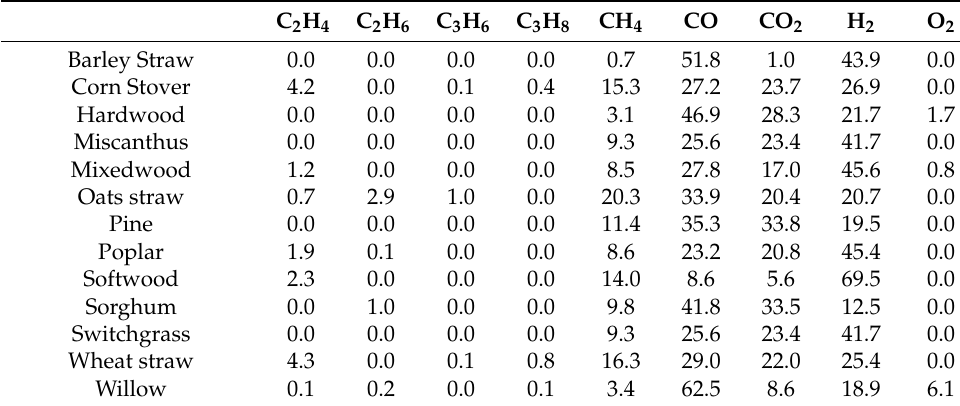
Table A1. Syngas composition used in IBGCC simulations.